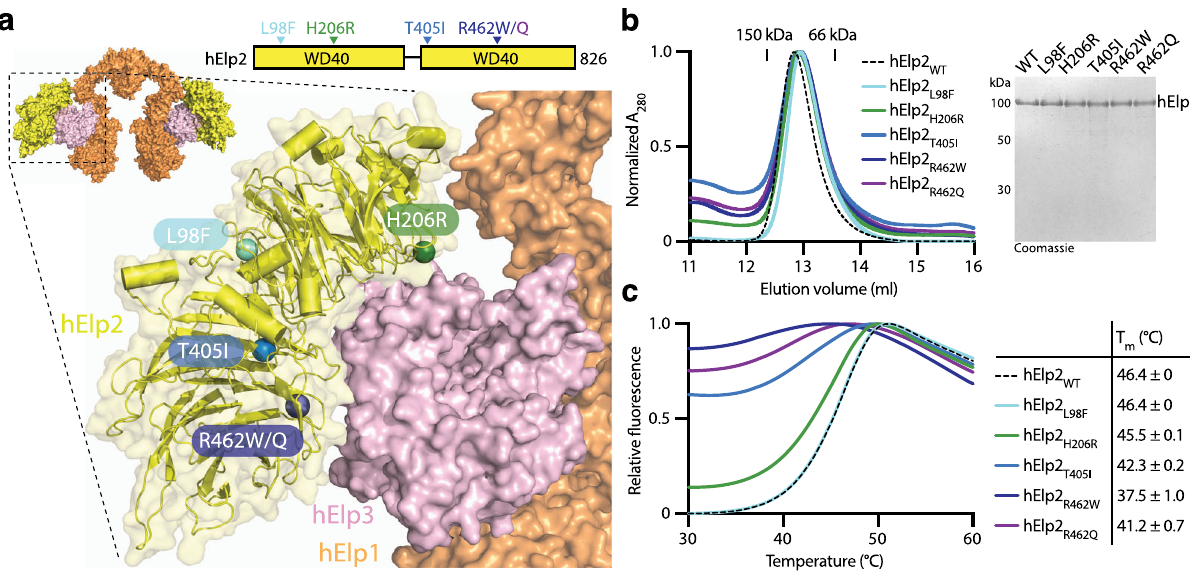
Fig. 2 Mutations found in patients with intellectual disability and autism impair the stability of hElp2 protein. a Localization of patient-derived mutations in the context of human ELP123 (hElp123) model prepared using Cryo-EM structure of yeast Elp123 (yElp123; PDB 6QK7). Color code for proteins: hElp1 — orange, hElp2 — yellow, hElp3 — pink. Mutations are depicted in different colors on hElp2 domain organization scheme and a close-up of hElp123 model. b Puri fi cation of wild-type (WT) and mutant hElp2. Gel fi ltration pro fi les from S200 Increase 10/300 GL column (left) and Coomassie- stained SDS-PAGE gel showing puri fi ed hElp2 variants (right; n = 3 independent experiments). c Averaged melting curves from thermal shift assay for hElp2 variants with calculated melting temperatures (Tm) (mean ± SD; n = 3 independent measurements). Source data are provided as a Source Data fi